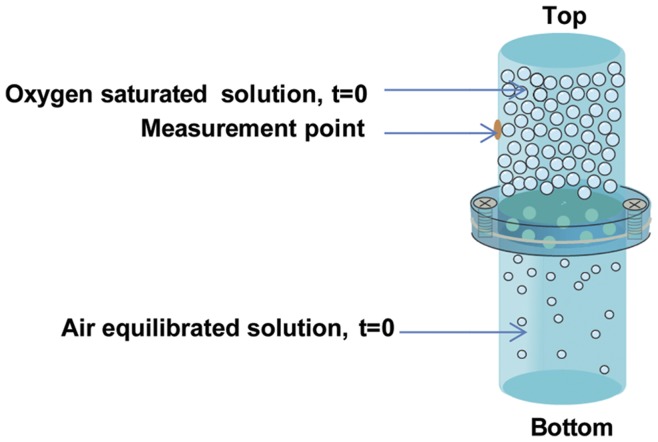
Oxygen diffusion in macroporous MAC scaffolds.Oxygen diffusion device allowing us to measure depletion of oxygen in the top chamber as diffusion occurs through the gel into the oxygen free bottom chamber.